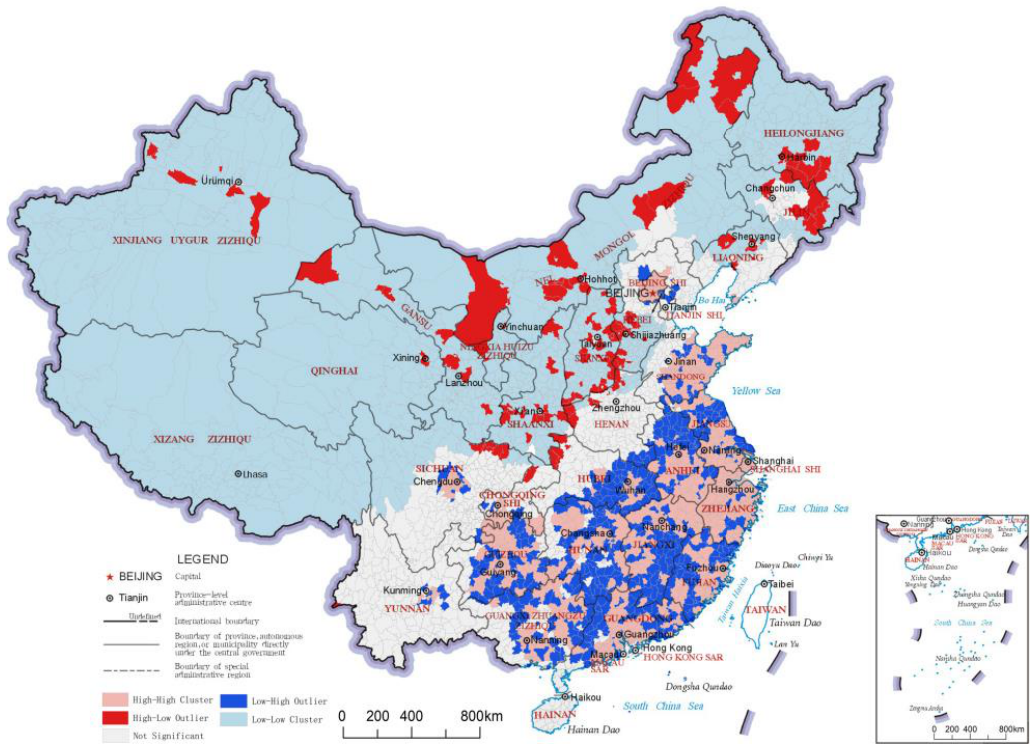
Figure 8. LISA cluster map of cultural service indices of the county-level regions in China.